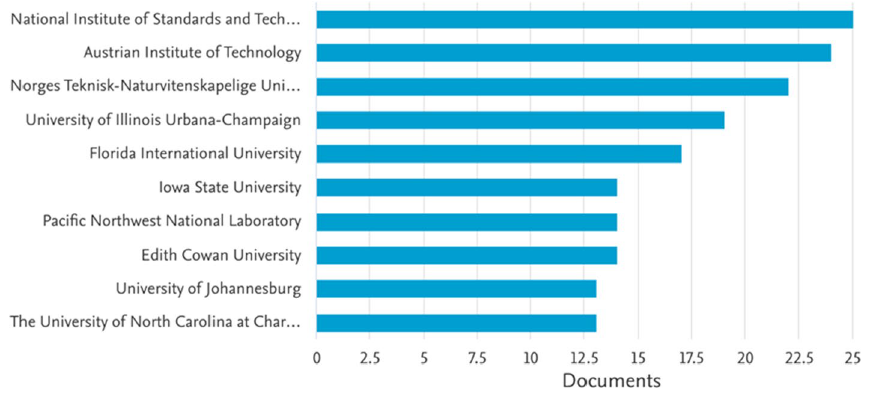
Fig. 3 The number of publication on cybersecurity by affiliation since 2000